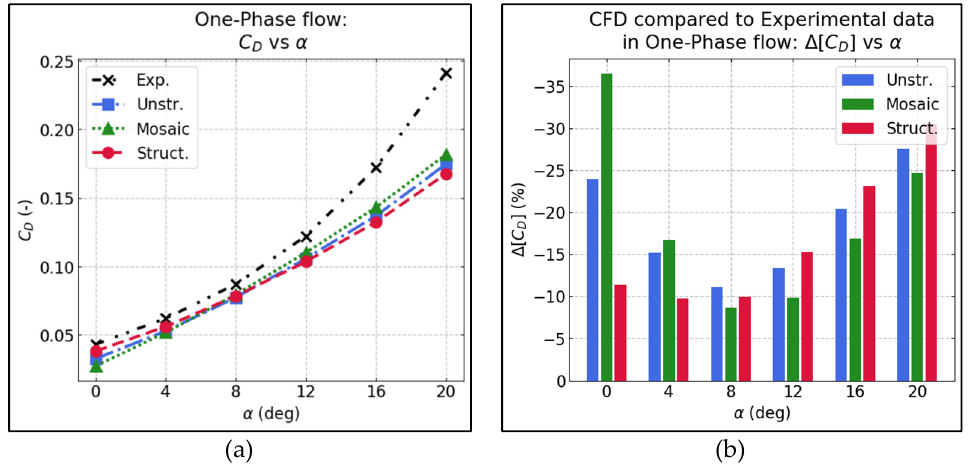
Figure 10. ( a ) Drag coefficient of wing from numerical simulations under 3 different meshes and experiment ( b ) Deviation of drag coefficient from simulations compared to experimental results.